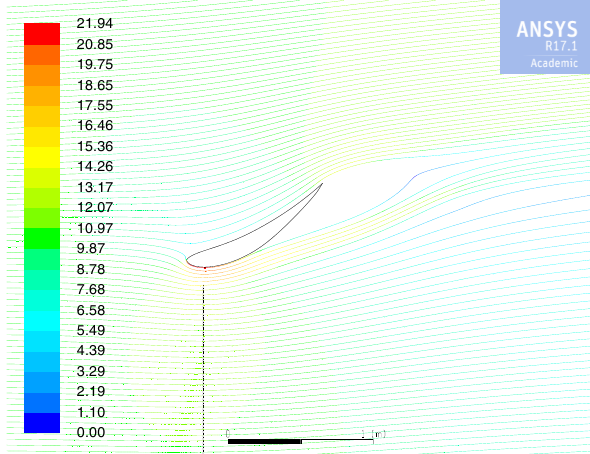
Figure 8. Streamlines at α = 30 ◦ (the streamlines are colored based on velocity magnitude in ms − 1